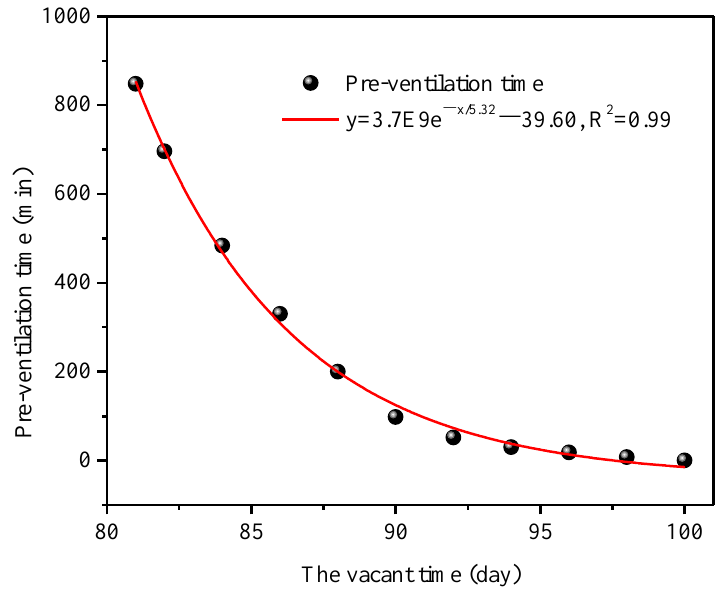
Figure 11. The relationship between the pre-ventilation time and the vacant time.